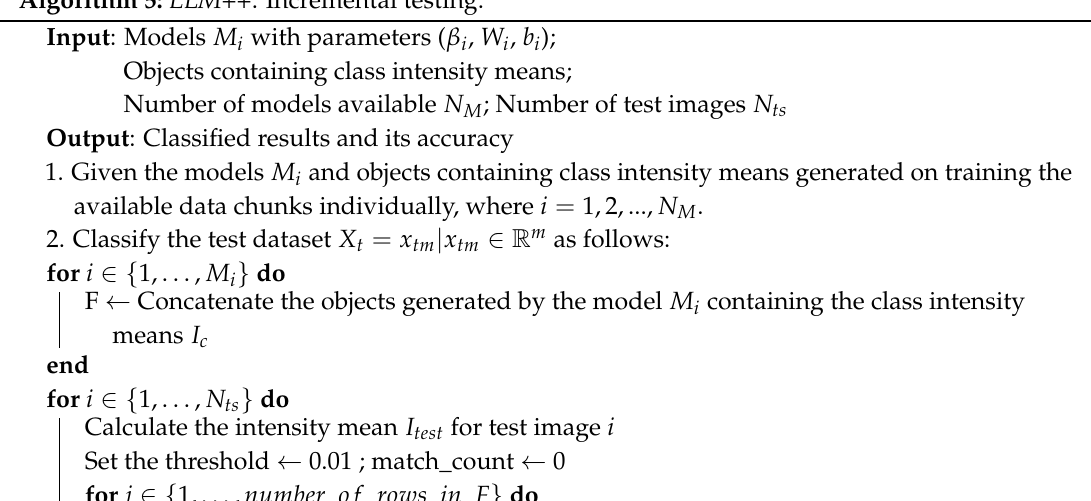
Algorithm 5: ELM++ : Incremental